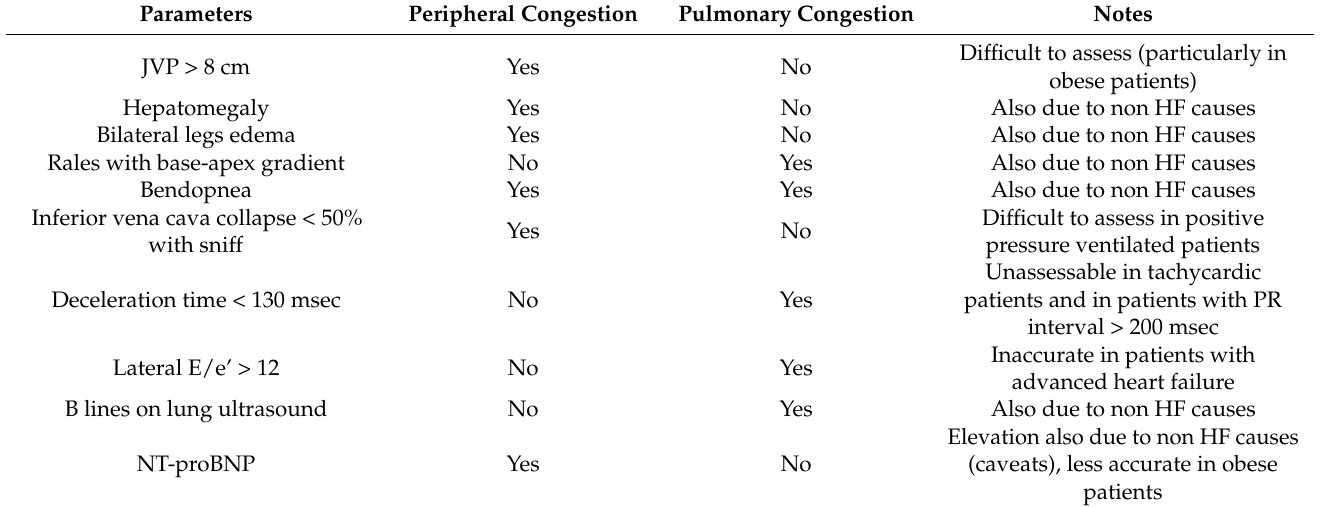
Table 1. Clinical, echocardiographic, and laboratory parameters used for the assessment of congestion in clinical practice. JVP: Jugular Venous Pulsation. HF: Heart Failure NT-proBNP: N-terminal fragment pro B-type Natriuretic